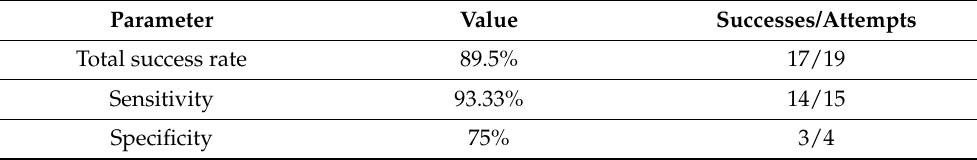
Table 4. Parameters used to calculate the total DeMeester parameter.